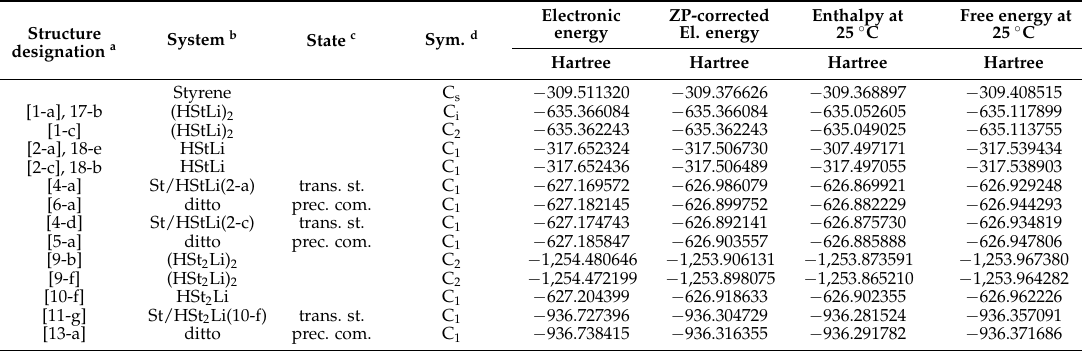
Table A2. Calculated energies in cyclohexane for the important structures discussed in the gas phase sections.